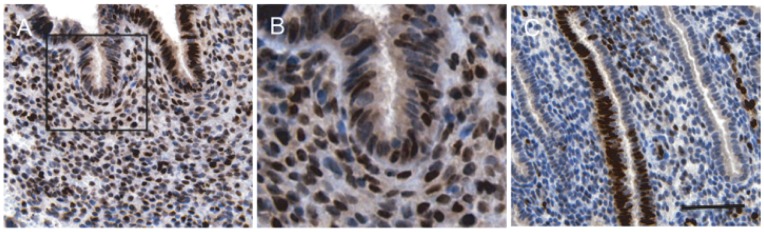
Representative IL-33 expression in mid-secretory human endometrium.Tissue sections were deparaffinised, rehydrated and stained with IL-33-specific antibody. A total of 12 biopsies from control subjects were analyzed. (A) Strong nuclear IL-33 immunoreactivity was observed in both the stromal and epithelial cell compartment (original magnification ×20). (B) Higher (×50) magnification of the indicated area also shows diffuse cytoplasmic IL-33 staining, especially near the luminal epithelium (C) In some specimens, IL-33 staining was very heterogeneous. For example, neighboring epithelial cells with a gland could be intensely positive and negative for IL-33 expression. (Scale Bar: 100 µm).